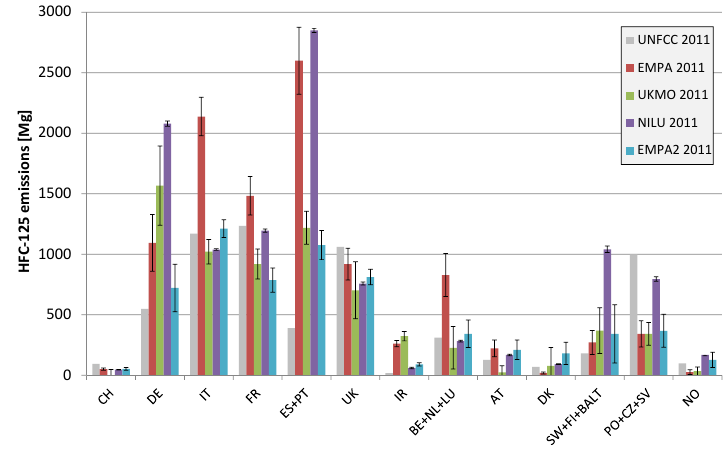
Figure 12. Country-aggregated posterior emissions of HFC-125 (experiment